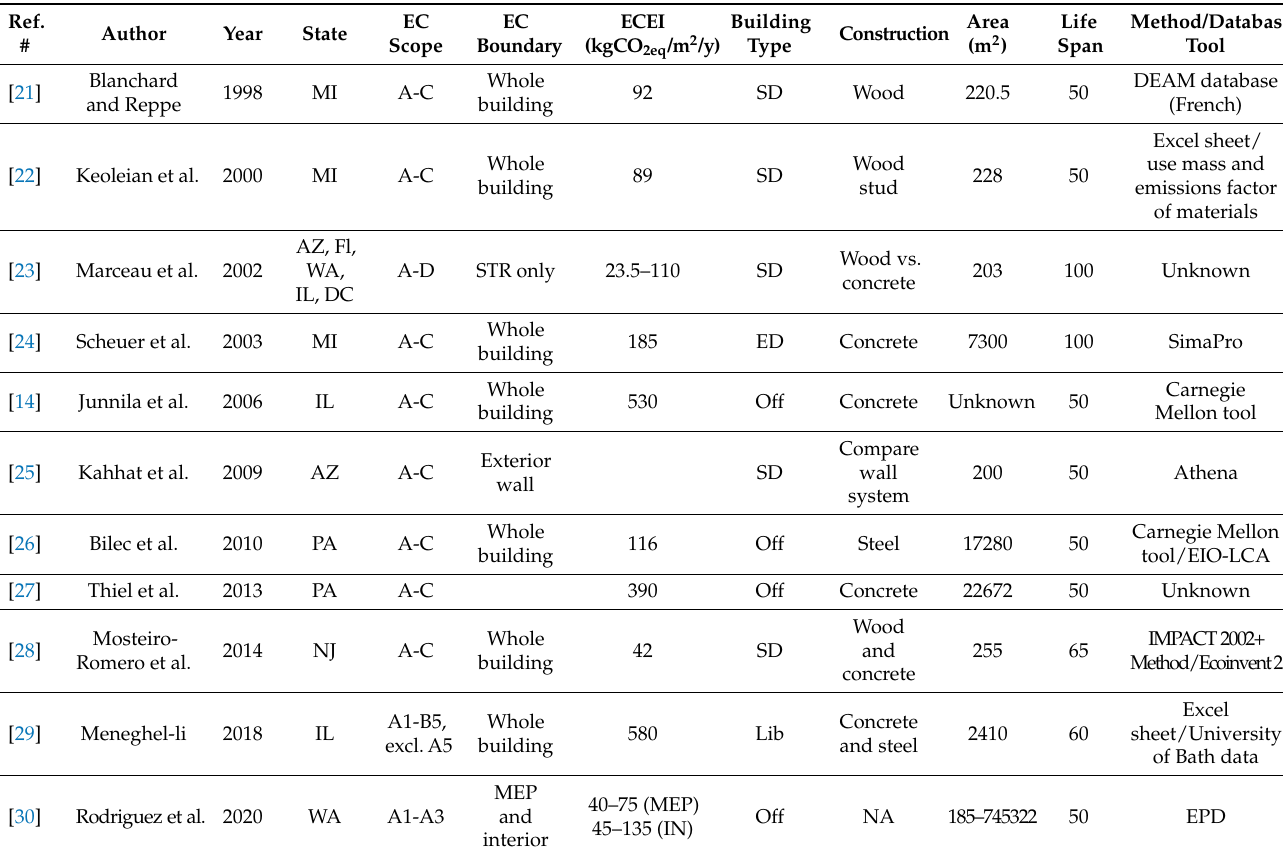
Table 1. Previous studies of embodied carbon emissions of US